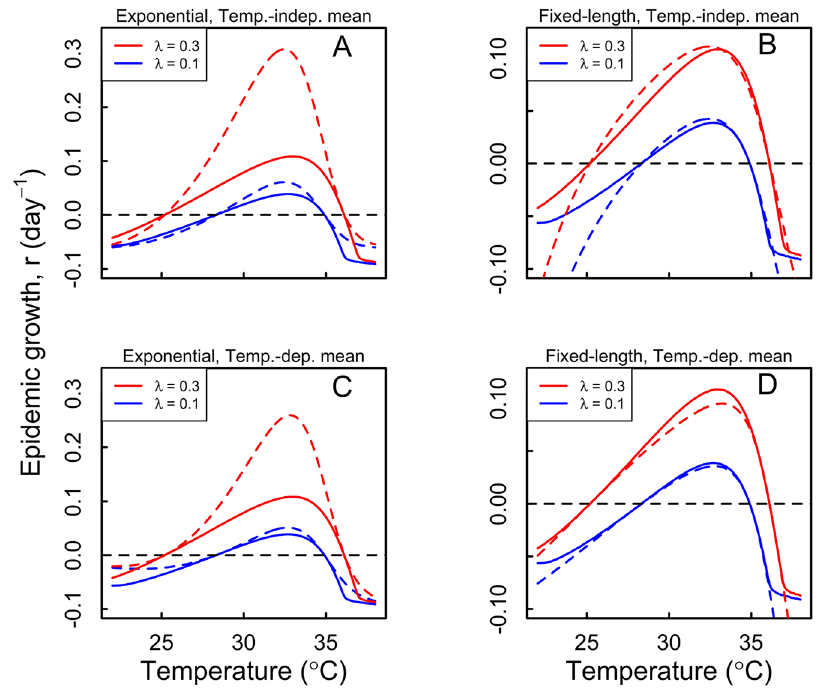
Fig 5. DENV epidemic growth rate, r , for high (red) and low (blue) mosquito densities based on our full model and other approximations. The top panels show comparisons of the full model estimates (solid lines) with those based on temperature independent,exponentially distributed (A) and fixed-length(B) generationintervals (mean = 16 days [34]) (dashedlines). The bottom panels show comparisons of estimates of the full model (solid lines) with those based on exponentially distributed (C) and fixed-length (D) generation intervals (dashedlines), with their mean values at each temperature set to the correspondingmean from the full